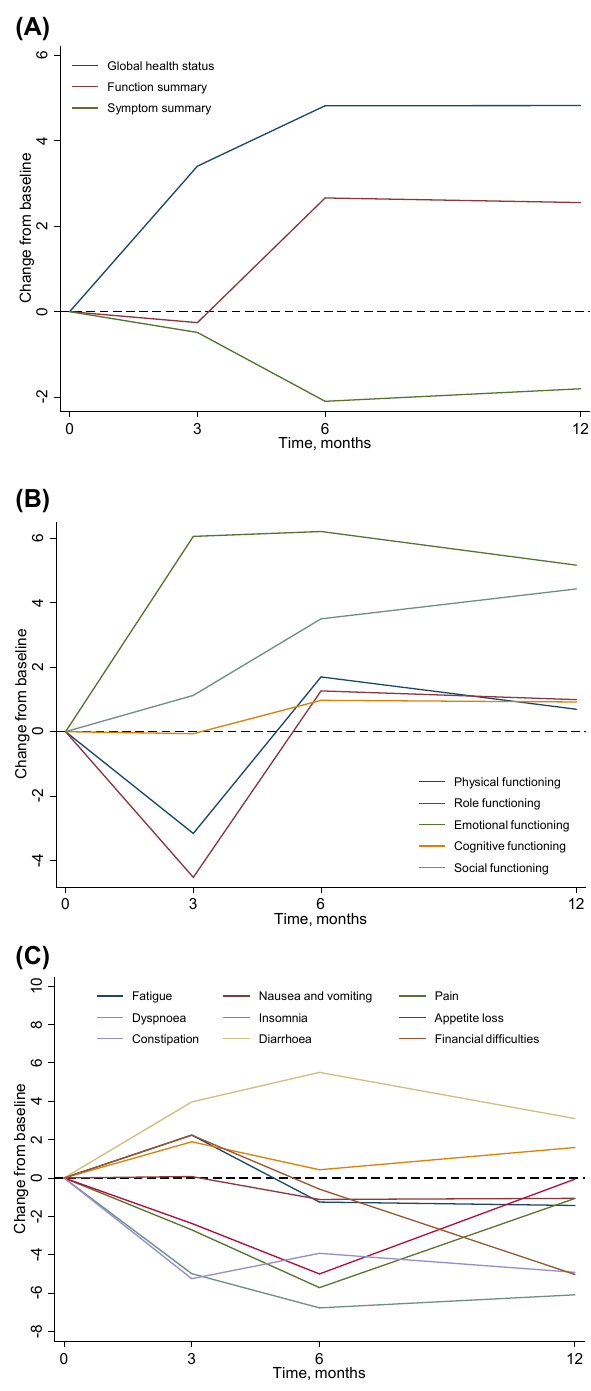
Figure 1: Plots of adjusted mean change from baseline-by-time for (A) global health status, functional scale scores and symptom scale scores, (B) functional scale scores, and (C) symptom scale scores. after CRS and HIPEC. The decreases in functional scales recovered to baseline by one year post-surgery. At 12 months, both emotional and social functioning scores improved compared to baseline. Insomnia andconstipationsymptomswereimprovedandmoreorlesssustained up to 12 months. Diarrhoea symptoms